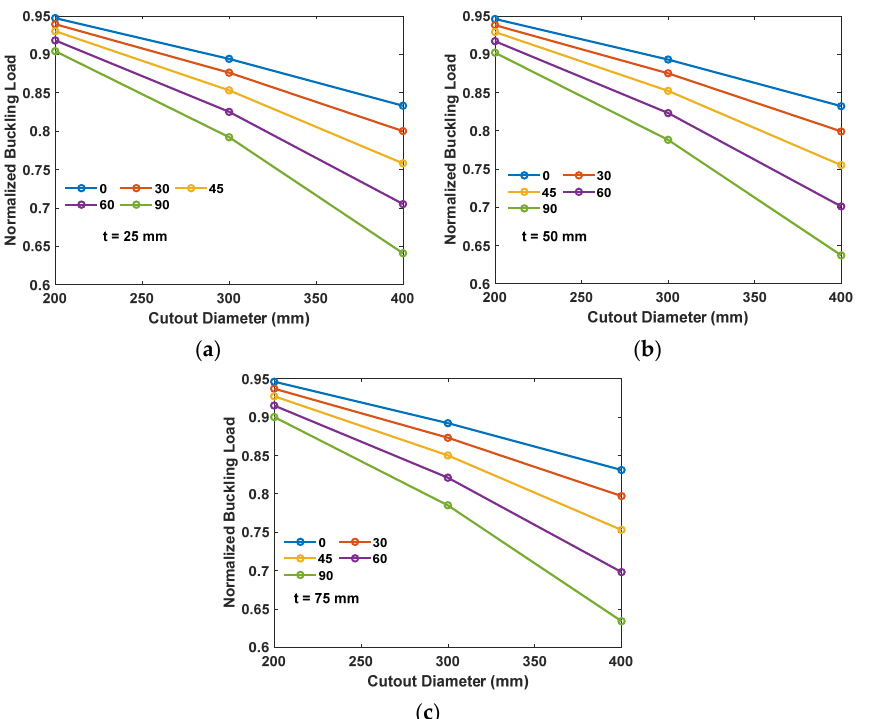
Figure 4. The variation of the cutout arrangements on the normalized buckling load for ( a ) t = 25 mm, ( b ) t = 50 mm, and ( c ) t = 75 mm with various plate thickness. In order to study the yielding of the FGM plate, the Von Mises stress is calculated for various cases. The Von Mises stress predicts the yielding of materials under complex load ‐ ings subjected to uniaxial tensile stress. Figure 5 shows the Von Mises stress of FGM plates with various cutouts arrangements with a plate thickness of 50 mm and a circular diame ‐ ter of 200 mm.